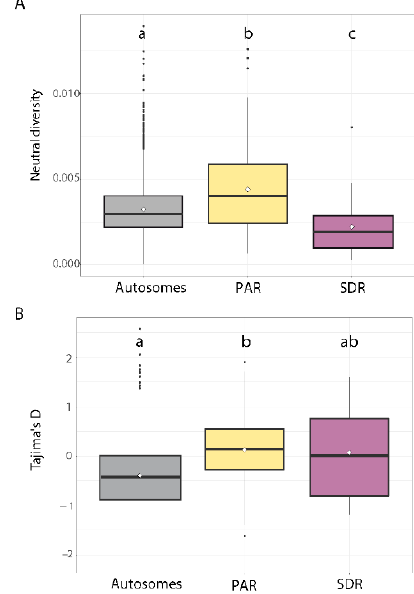
Figure 2. Population genetics statistics for the three Ectocarpus siliculosus genomic compartments: autosomes, pseudoautosomal regions (PAR) and sex-determining region (SDR). ( A ) Boxplots of neutral diversity ( π ), calculated in 1 kb windows without overlap; ( B ) Boxplots of Tajima’s D , calculated in 1 kb windows without overlap. The mean values are represented by the diamond shape. Letters above the boxplots denote significant differences (Wilcoxon test, p < 0.0005).